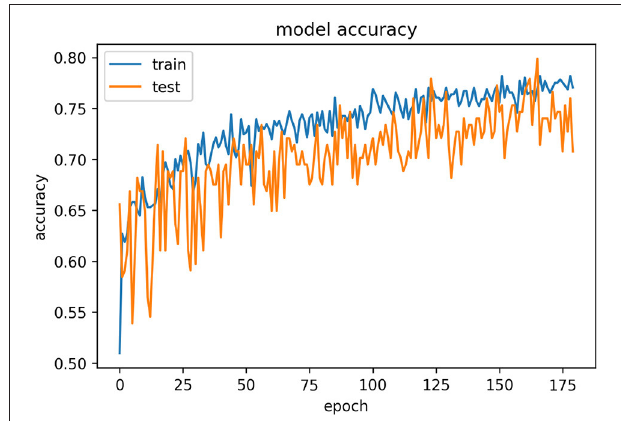
FIGURE 9 | Epochs vs. accuracy graph for the VGG16